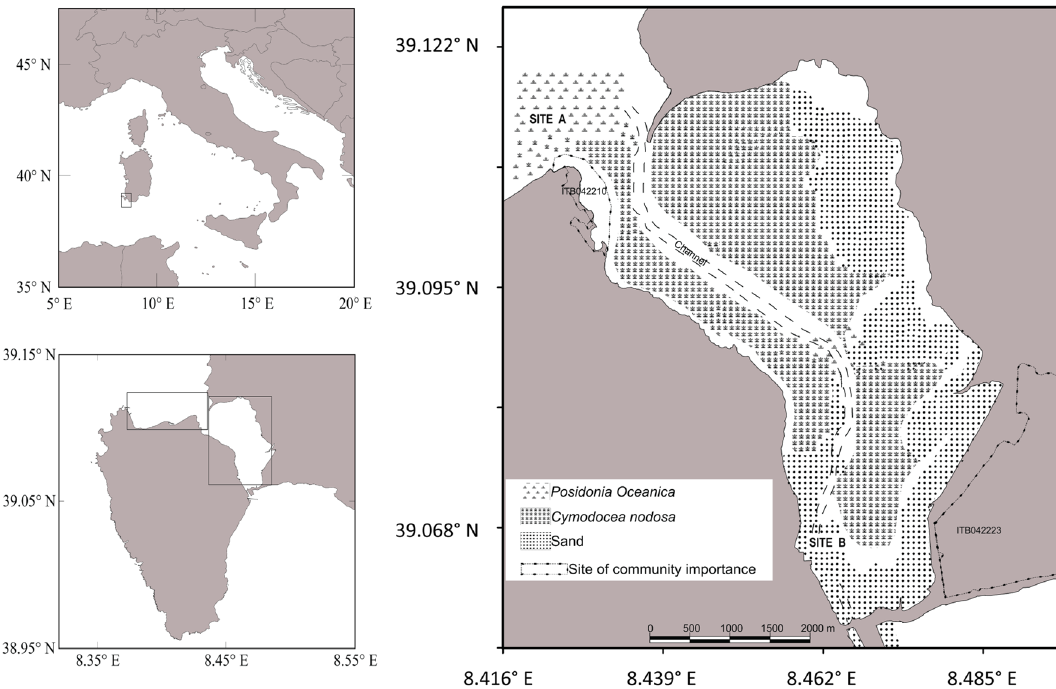
Figure 2. Map of the sampling sites in Sant’Antioco, Sardinia, Italy. The map on the right shows the lagoon of Sant’Antioco and the distribution of different habitats in it (from: Secci et al. modified) 6